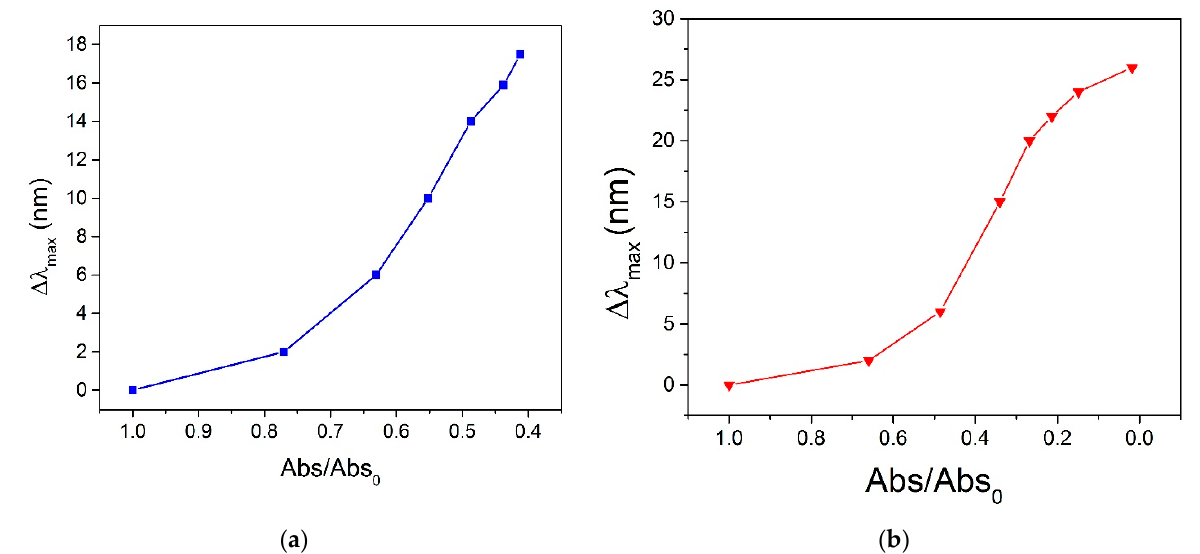
Figure 13. Hypsochromic shift and intensity decrease of the RhB characteristic peak during ( a ) catalytic and ( b ) photocatalytic reactions.